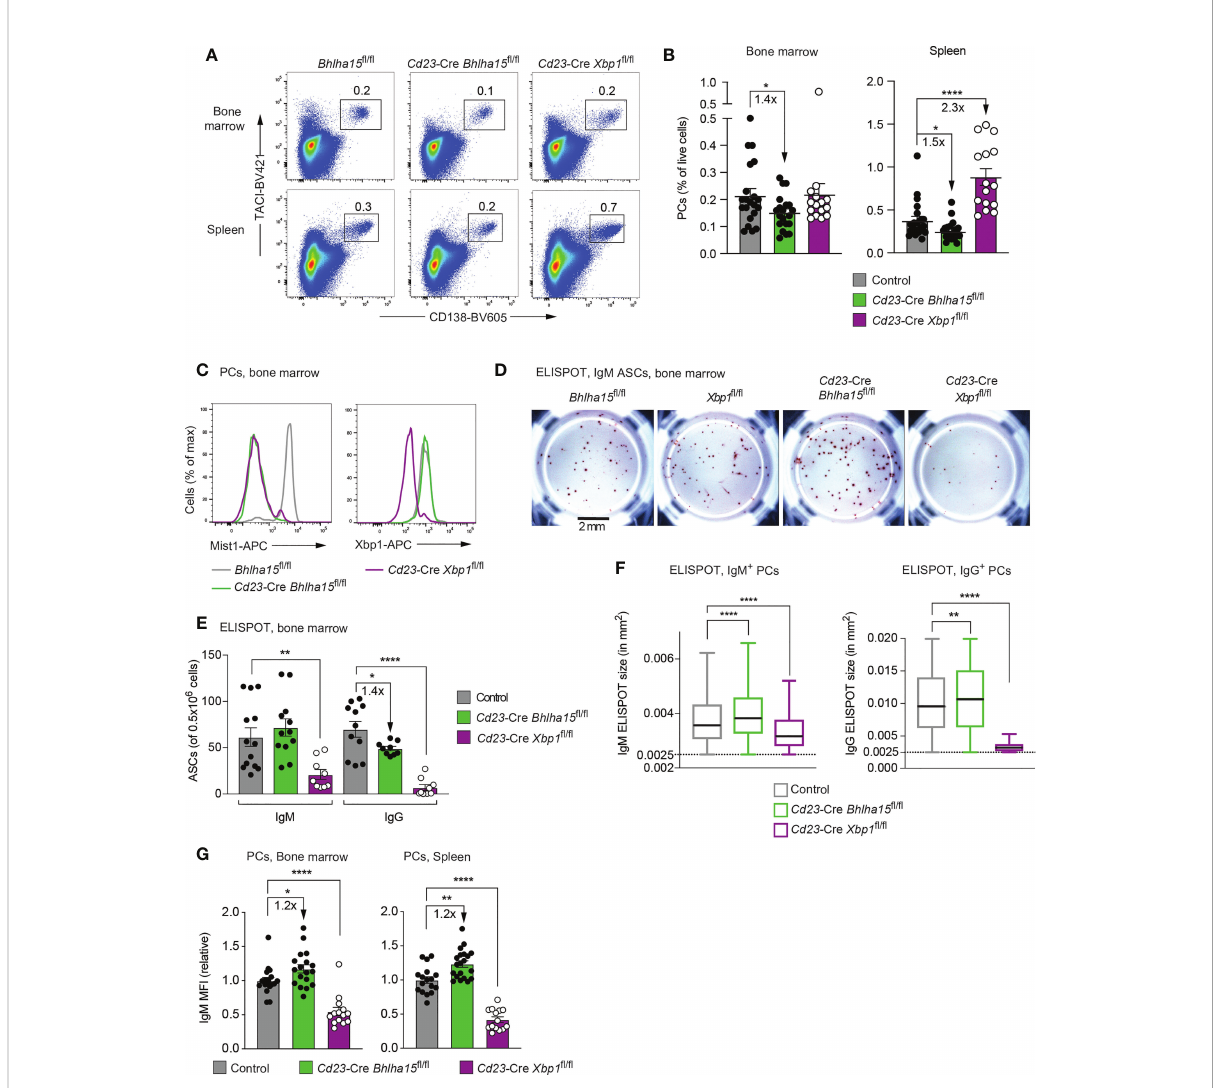
FIGURE 2 Reduced plasma cell numbers and increased antibody secretion in unimmunized Cd23 -Cre Bhlha15 fl / fl mice. (A) Flow-cytometric analysis of PCs (TACI + CD138 + ) in the spleen and bone marrow of 13-23-week-old mice of the indicated genotypes. The percentage of cells in the indicated gate is shown. One of 3 independent experiments with similar results is displayed. (B) The relative frequency of PCs in the bone marrow and spleen of 13- 23-week-old mice of the indicated genotypes is shown for 3 independent experiments ( n > 18 mice) per genotype. Bhlha15 fl / fl and Xbp1 fl / fl mice served as controls. (C) Expression of Mist1 and Xbp1 in PCs from the bone marrow of age-matched mice of the indicated genotypes, as determined by intracellular staining. One of two experiments is shown. (D – F) ELISPOT analysis of IgM and IgG antibody-secreting cells (ASC) from the bone marrow of age-matched mice of the indicated genotypes (see Methods). (D) Representative wells of an anti-IgM ELISPOT experiment. The scale bar indicates 2 mm. (E) Quanti fi cation of the number of IgM and IgG ASCs per 500,000 plated bone marrow cells. The combined data of two independent experiments are shown. (F) Size distribution of the antibody-containing dots, which were produced by the IgM and IgG ASCs shown in (E) . The dot sizes were automatically quanti fi ed by using the Fiji software (see Methods). Black lines indicate the median, and boxes represent the middle 50% of the data. Whiskers denote all values of the 1.5× interquartile range. Dots with a size of > 0.0025 mm 2 are analyzed. The results of one of 2 independent experiments are shown. (G) Quanti fi cation of the mean fl uorescence intensity (MFI) of intracellular IgM staining in plasma cells (TACI + CD138 + ) from the bone marrow (left) and spleen (right) of 13-23-week-old mice of the indicated genotypes. The MFI values of 3 independent experiments were normalized relative to those of the control mice (mean value set to 1). Statistical data are shown as mean values with SEM and were analyzed with the unpaired Student ’ s t test (B – G) or Mann-Whitney test (F) ; * P < 0.05, ** P < 0.01, **** P < 0.0001. Each dot (B – G) represents one